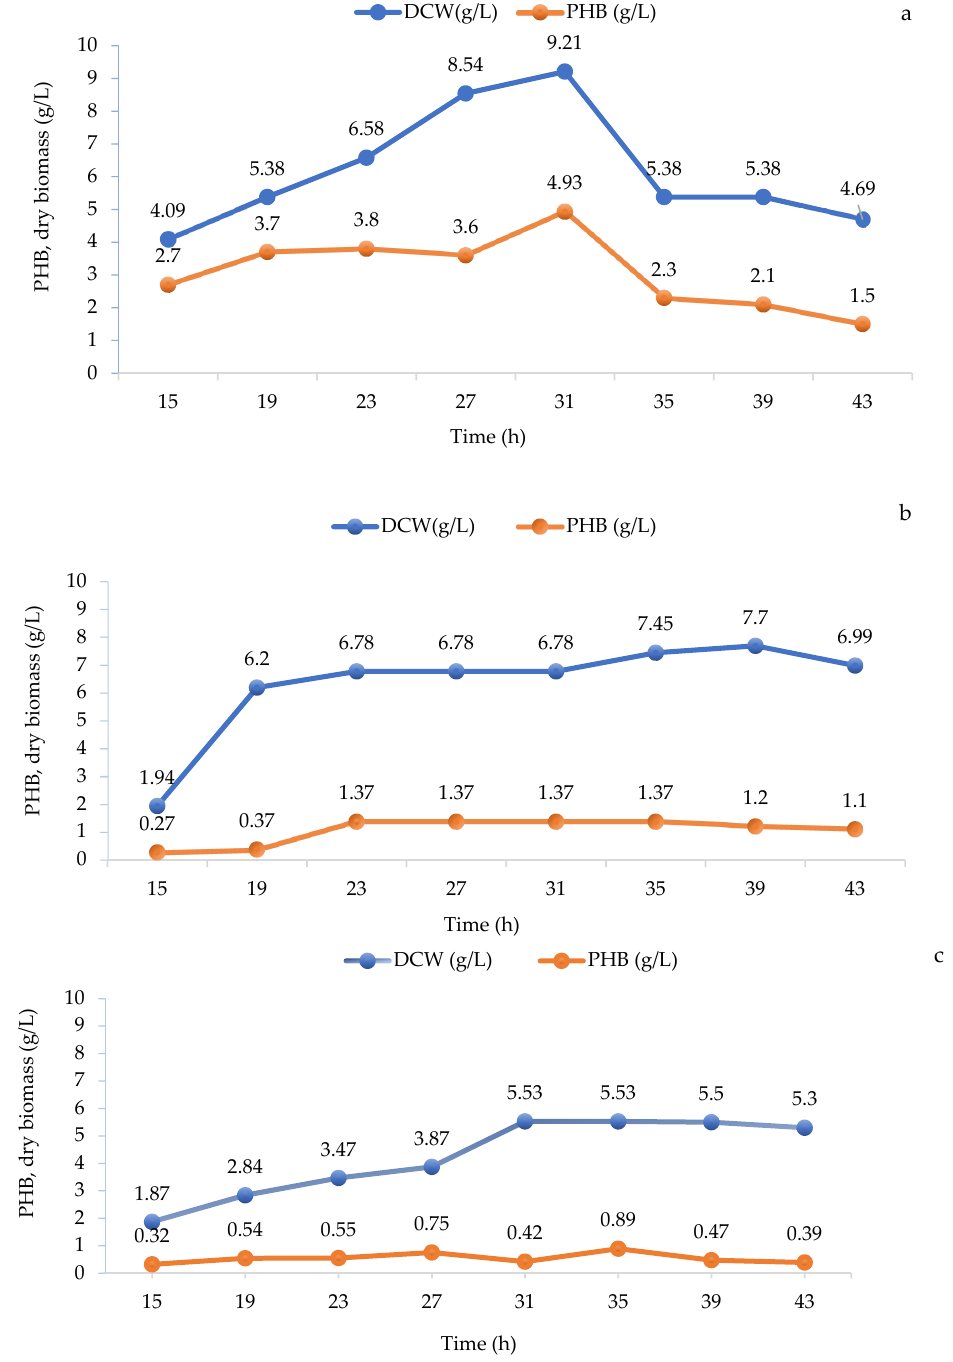
Figure 3. Specific rate of P(3HB) formation and specific rate of formation of residual biomass under conditions of oxygen deficiency in RB medium (mineral medium with the addition of bean broth) of strain RAZ 3 ( a ); in Burke’s medium strain RAZ 3 ( b ); in the mineral environment Ⅱ strain RAZ 3 ( c ). 3.1.3. The Molecular Identification of Selected P(3HB) Positive Bacterial Isolates The molecular identification of selected P(3HB) positive bacterial isolates was con- ducted by subjecting them to 16S rRNA amplification analysis Table 4. Table 4. М olecular identification of selected P(3HB) positive bacterial isolates. Strain